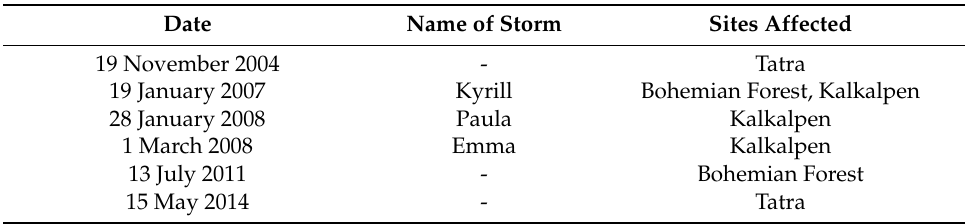
Table 1. Overview of major storm events that affected the study sites within the observation period in which we mapped forest disturbances